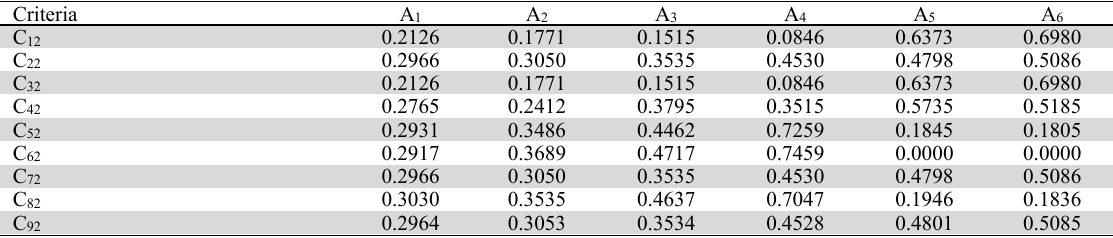
Normalised economic criteria decision matrix Criteria